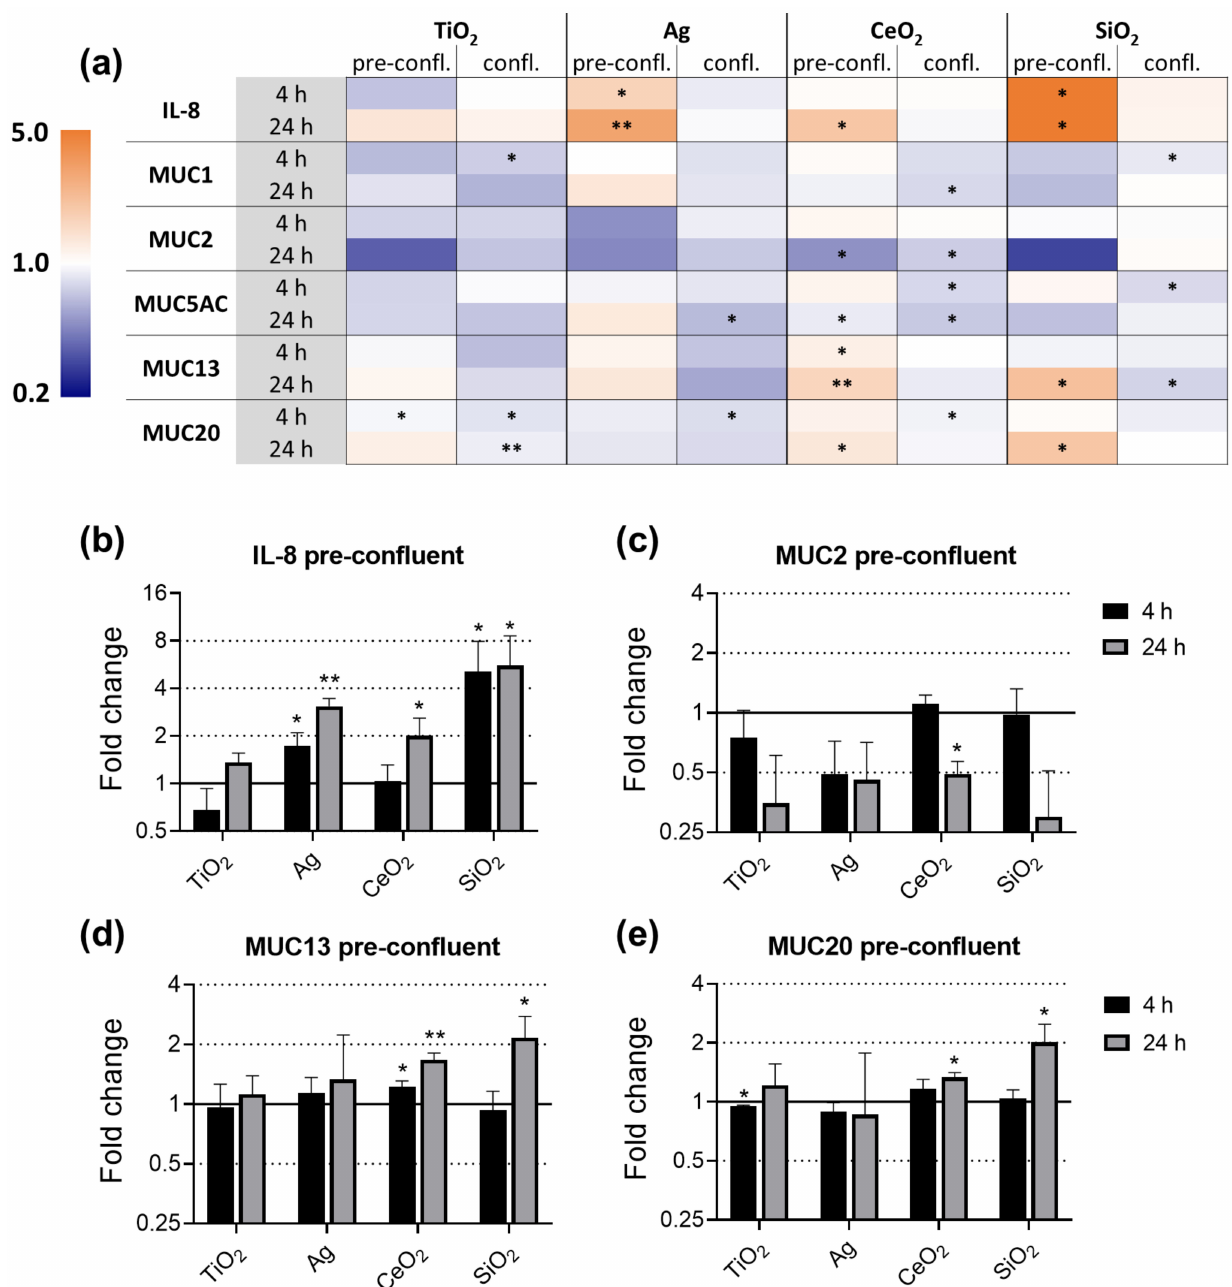
Figure 5. Gene expression of IL-8 and mucins in E12 cells upon exposure to TiO 2 , Ag, CeO 2 , and SiO 2 . Pre-confluent and confluent E12 cells were exposed to 80 µ g/cm 2 ENM for 4 h and 24 h. The relative gene expression of IL-8, MUC1, MUC2, MUC5AC, MUC13, and MUC20 was assessed by qRT-PCR. The results were normalized to the unexposed negative controls and β -Actin as reference gene. The depicted fold changes with SD were derived from the mean and SD of the ∆∆ C T -values of N = 3 independent experiments ( t -test; * p ≤ 0.05; ** p ≤ 0.01). The gene expression of all investigated genes is depicted as heatmap ( a ). As an extract, the gene expression of IL-8 ( b ), MUC2 ( c ), MUC13 ( d ) and MUC20 ( e ) in pre-confluent E12 cells is depicted